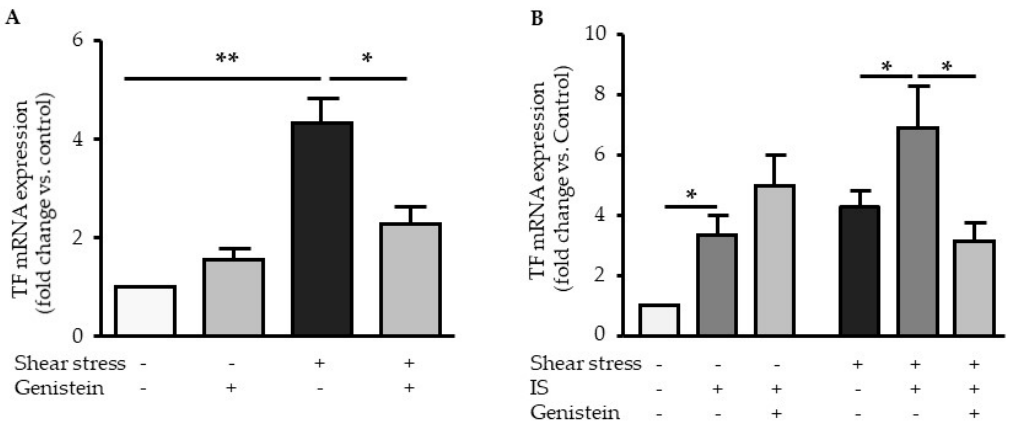
Figure 6. E ff ect of genistein on TF induction by shear stress and IS. ( A ) E ff ect of genistein (100 µ M) on mRNA expression of TF after a 4 h of shear stress (5 dynes / cm 2 ). ( B ) E ff ect of genistein (100 µ M) on mRNA expression of TF after a 4 h stimulation with IS (200 µ M) under static or shear stress (flow) conditions. Data, expressed as mRNA fold change vs. control, represent the mean ± SEM of 5 independent experiments. * p < 0.05, ** p < 0.01.